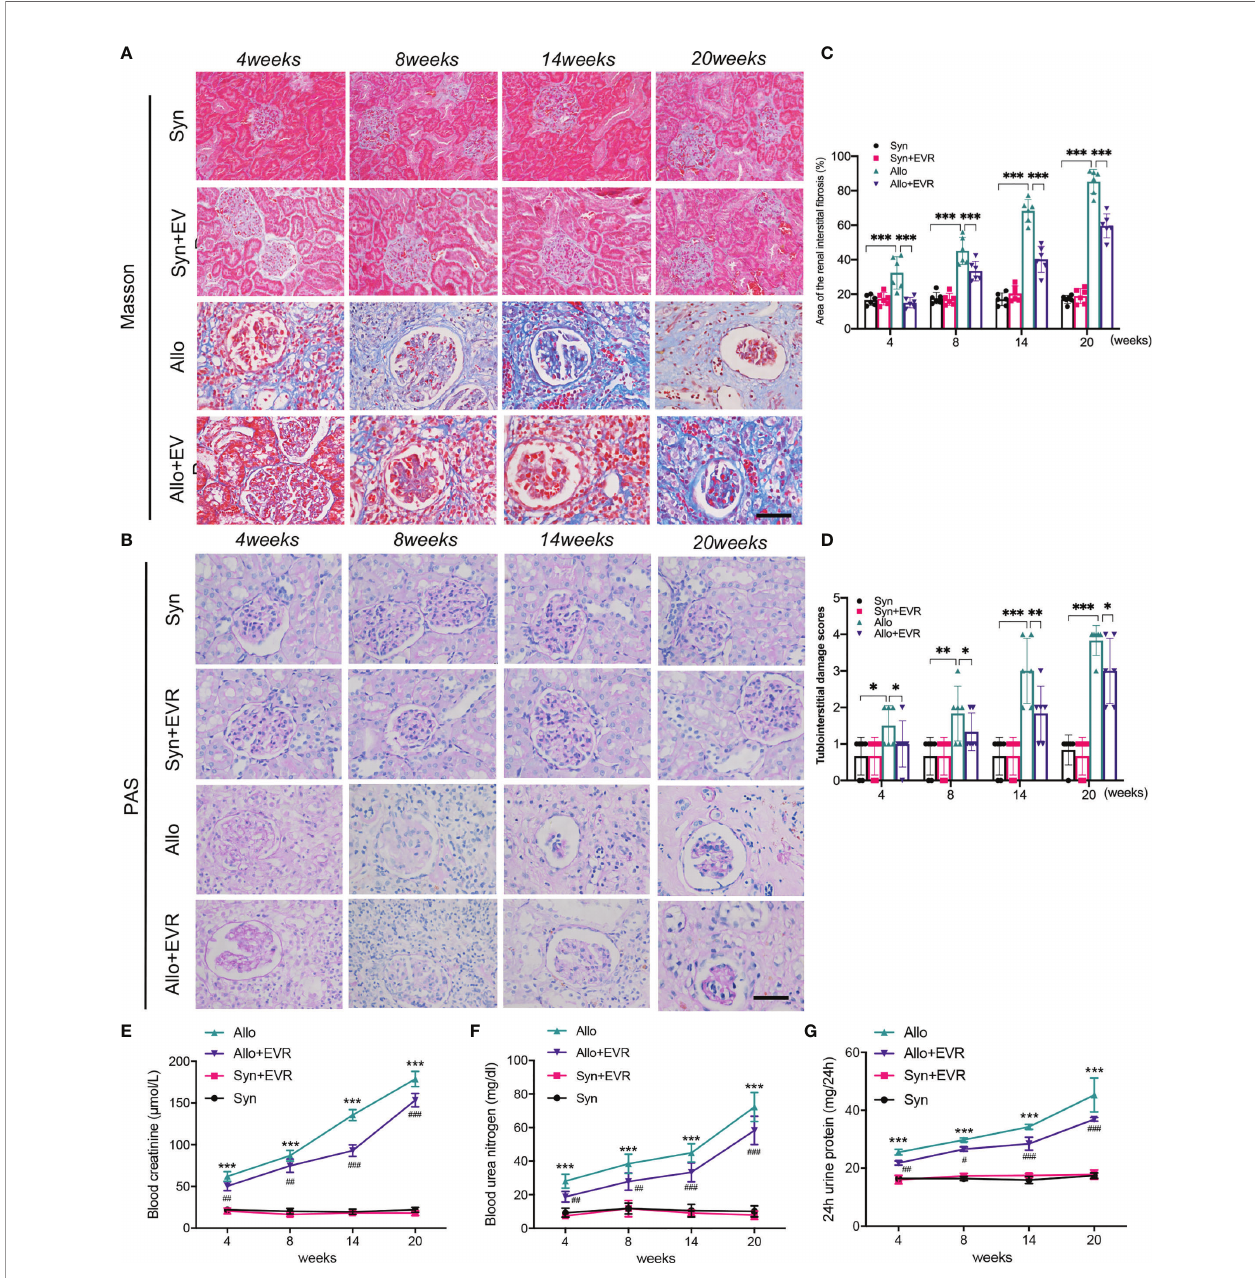
FIGURE 1 | EVR prevented allograft renal function impairment and renal interstitial fi brosis in CAD rat model. (A, B) Representative images ( n = 6) of Masson ’ s trichrome staining and PAS staining (scale bar: 25 m m) from kidneys of different treatment group rats. (C) Semi-quantitative analyses results of Masson ’ s trichrome staining positive area that represented the area of the renal interstitial fi brosis from kidneys of different treatment group rats. Values represented the mean ± SD ( n = 6, *** p < 0.001). (D) The statistical analyses of tubulointerstitial damage scores in different treatment group rats. Values represented the mean ± SD ( n = 6, * p < 0.05, ** p < 0.01, *** p < 0.001). (E – G) Changes of renal function parameters — serum Cr, BUN, and 24-h urine protein of different treatment group rats. Values represented the mean ± SD ( n = 6, *** p < 0.001 compared with control group, # P < 0.05, ## P < 0.01, ### p < 0.001 compared with Allo group); EVR, everolimus; PAS,